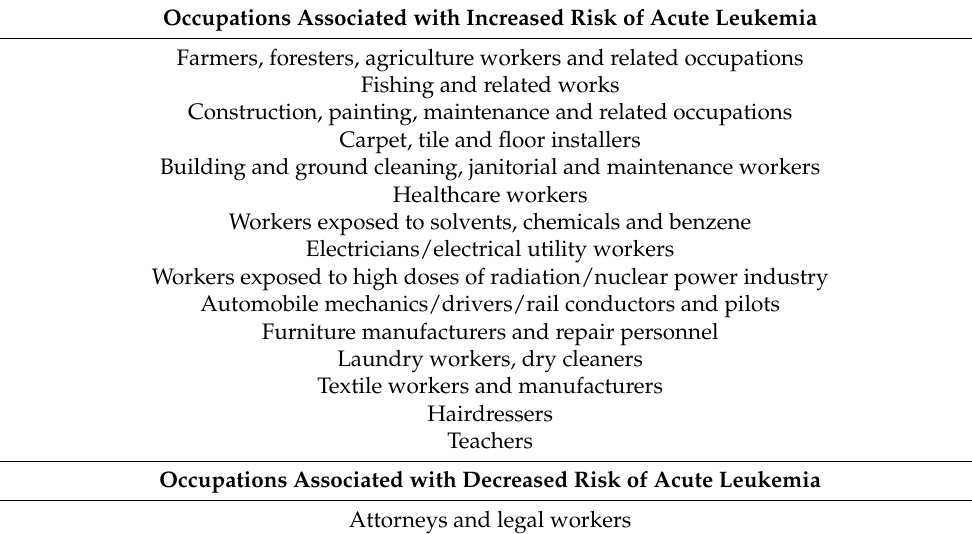
Table 3. Occupations with an Increased and Decreased Risk of Acute